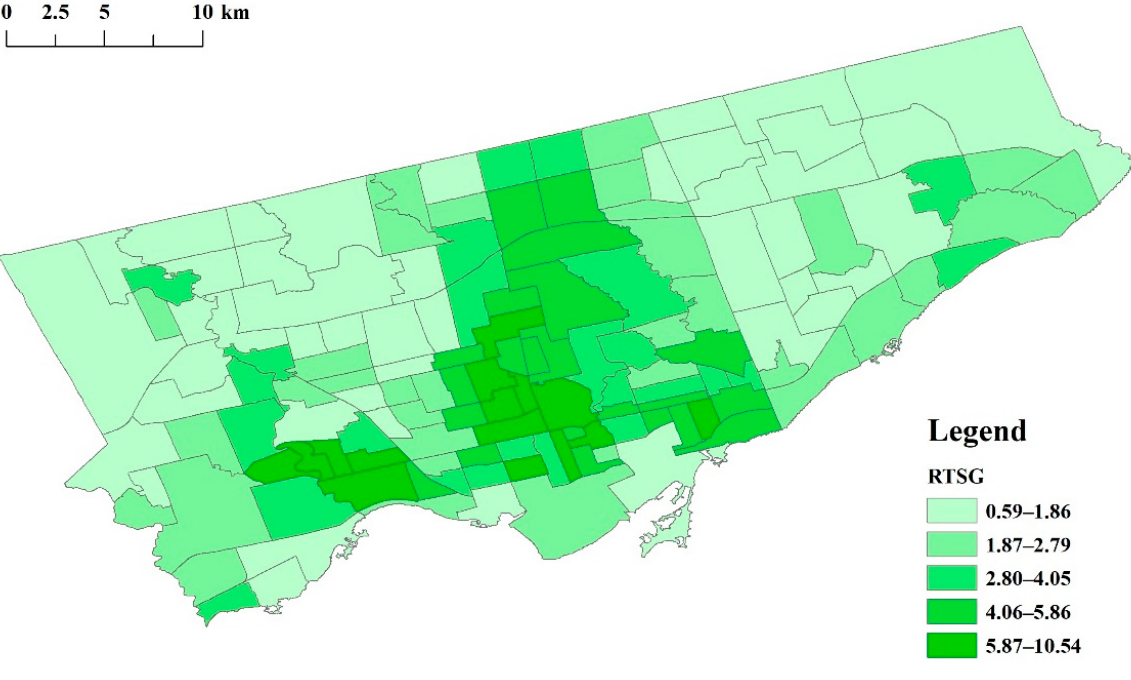
Figure A10. Distribution of the ratio of trees to shrubs–grass (RTSG).